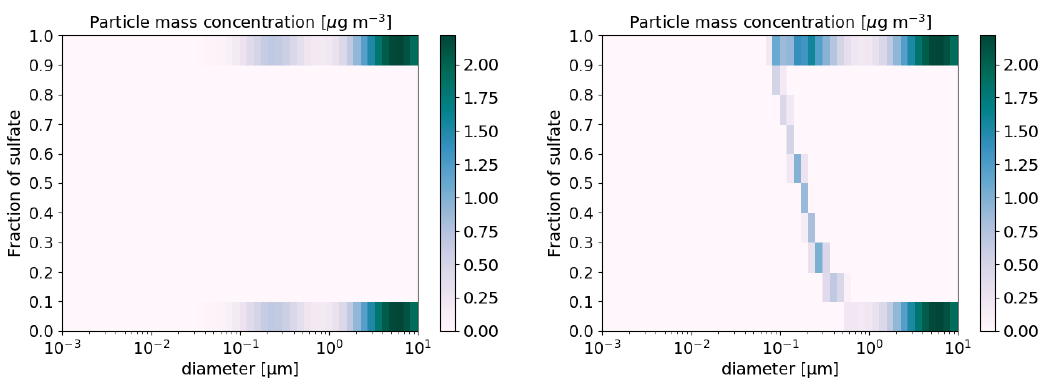
Figure 8. Particle mass concentration ( µ g m − 3 ) for the condensation test case, as a function of size and composition: initial concentrations ( left ) and after 12 h of simulation ( right